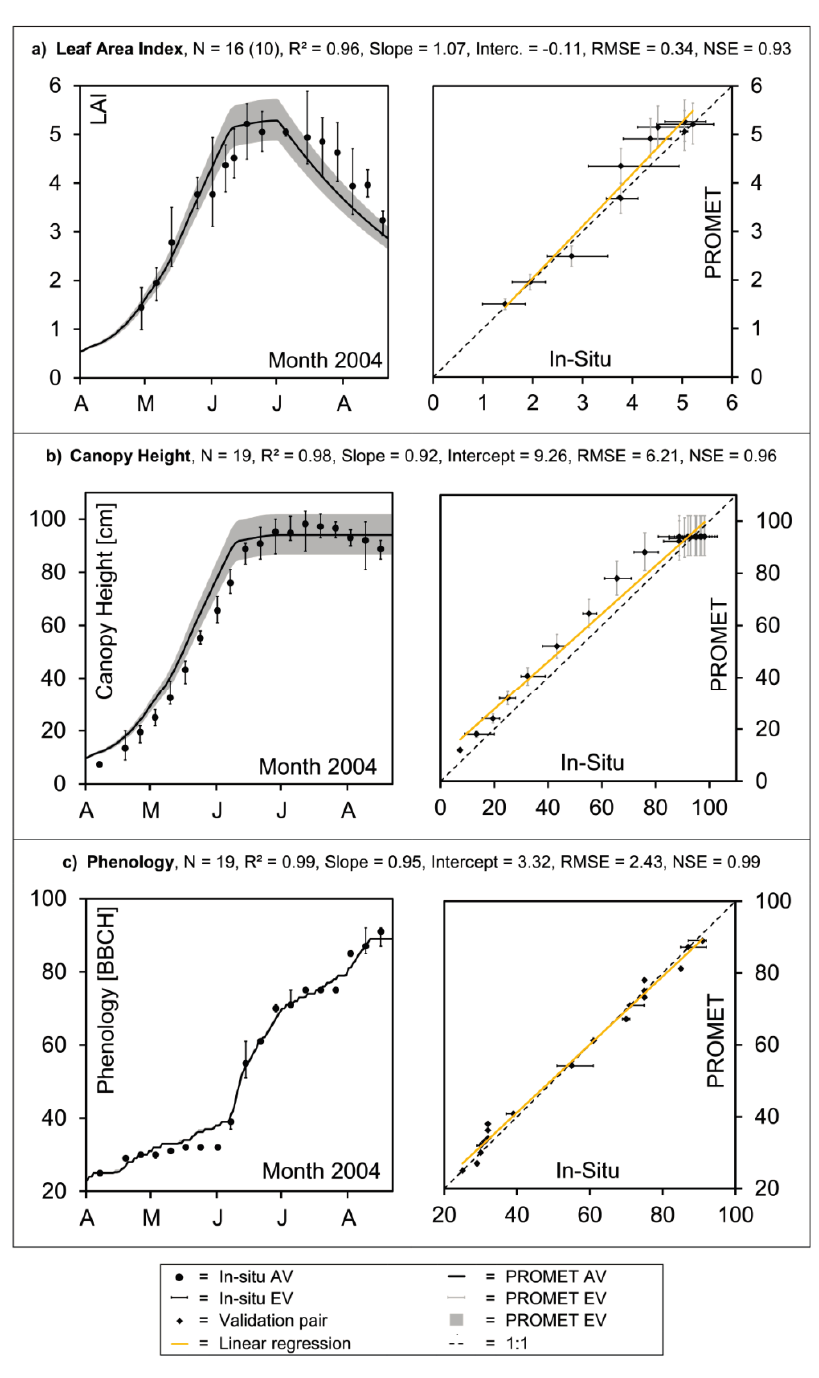
Figure 5. Validation of structural canopy variables of winter wheat in southern Germany: Modelled values vs . in situ measurements: ( a ) leaf area index, ( b ) canopy height, ( c )